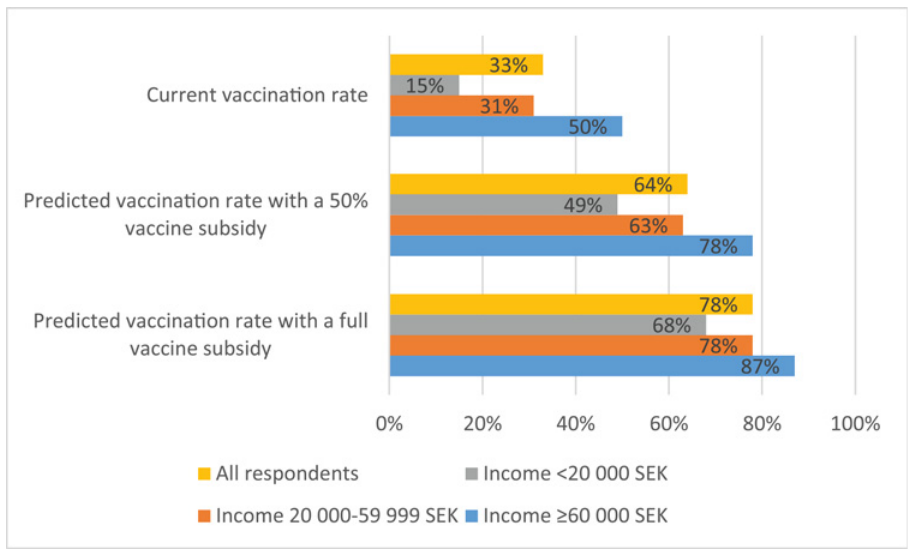
Fig 2. Predicted vaccination rates with a TBE vaccine subsidy in TBE risk areas (%). All respondents and respondents in different income groups (pre-tax monthly household income in